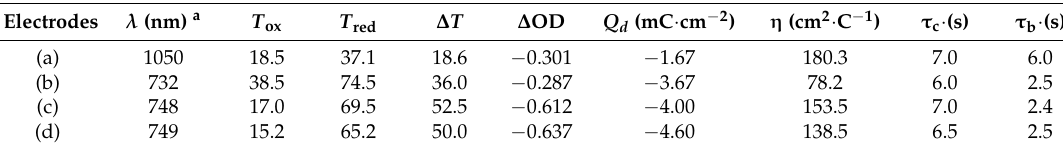
Table 2. Optical and electrochemical properties investigated at selected applied wavelength for the electrodes.